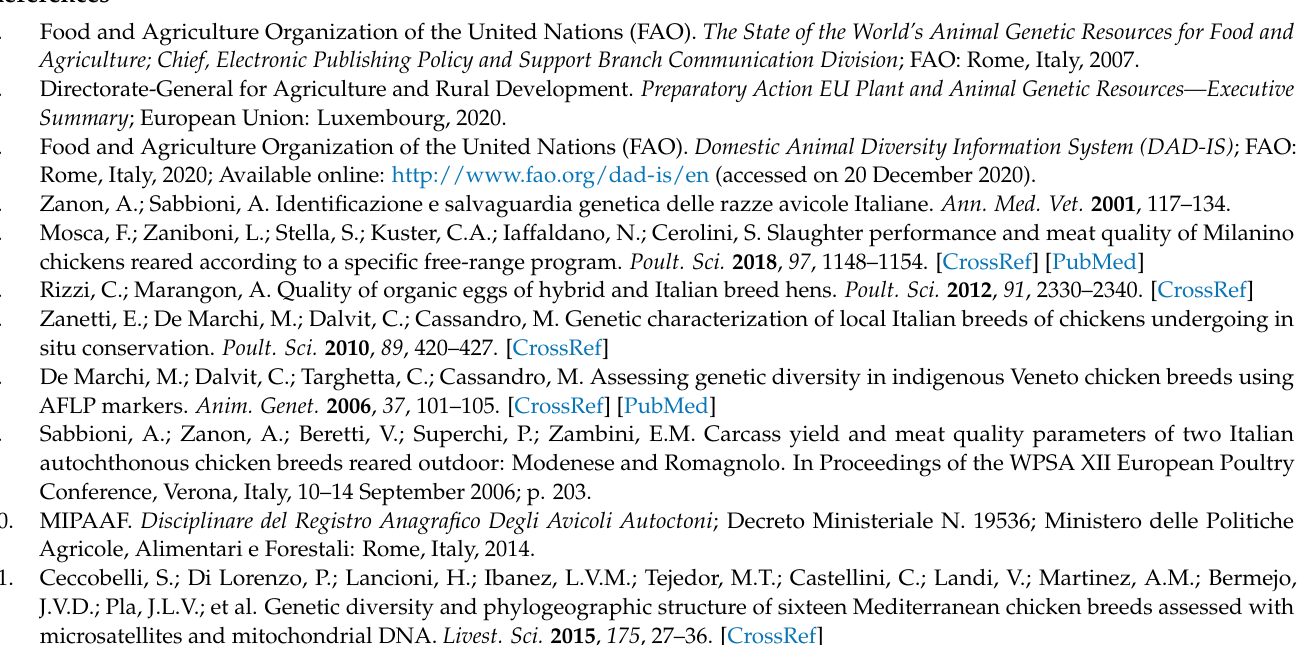
from all breeders and divided according to breeder category, Table S2: Environmental housing conditions adopted: responses from all breeders and divided according to breeder category, Table S3: Pen cover and ground vegetation: responses from all breeders and divided according to breeder category, Table S4: Litter management: responses from all breeders and divided according to breeder category, Table S5: Pen furnishings: responses from all breeders and divided according to breeder category, Table S6: Self-production of feed primary materials: responses from all breeders and divided according to breeder category, Table S7: Flock vaccinations and medical treatments performed: responses from all breeders and divided according to breeder category, Table S8: Farm location and presence of a cold storage room for dead animals: responses from all breeders and divided according to breeder category, Table S9: Frequency of interventions against rodents: responses from all breeders and divided according to breeder